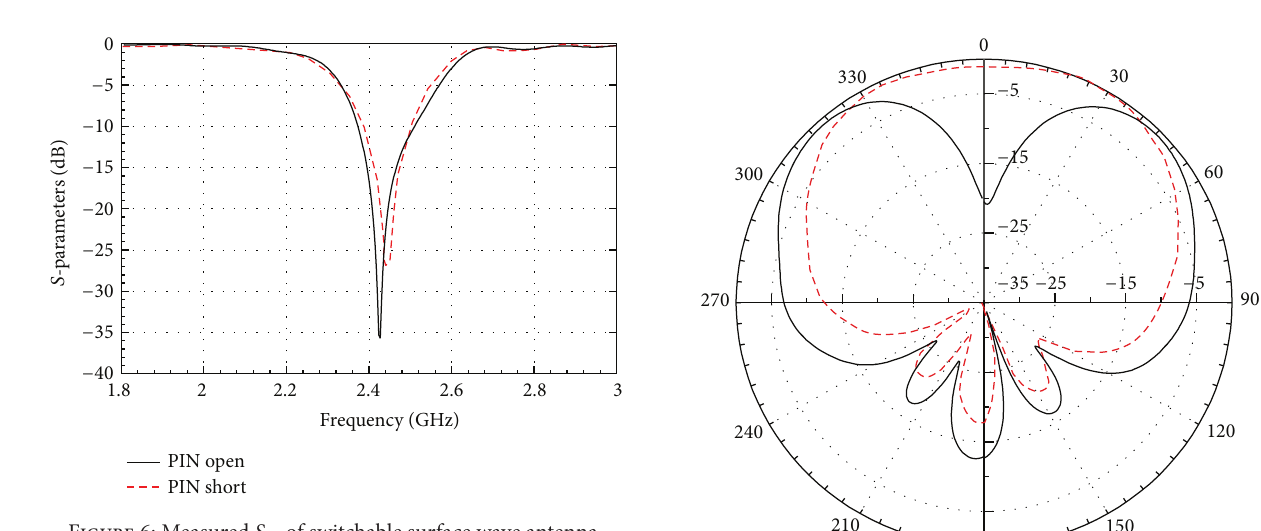
Figure 6: Measured S 11 of switchable surface wave antenna.